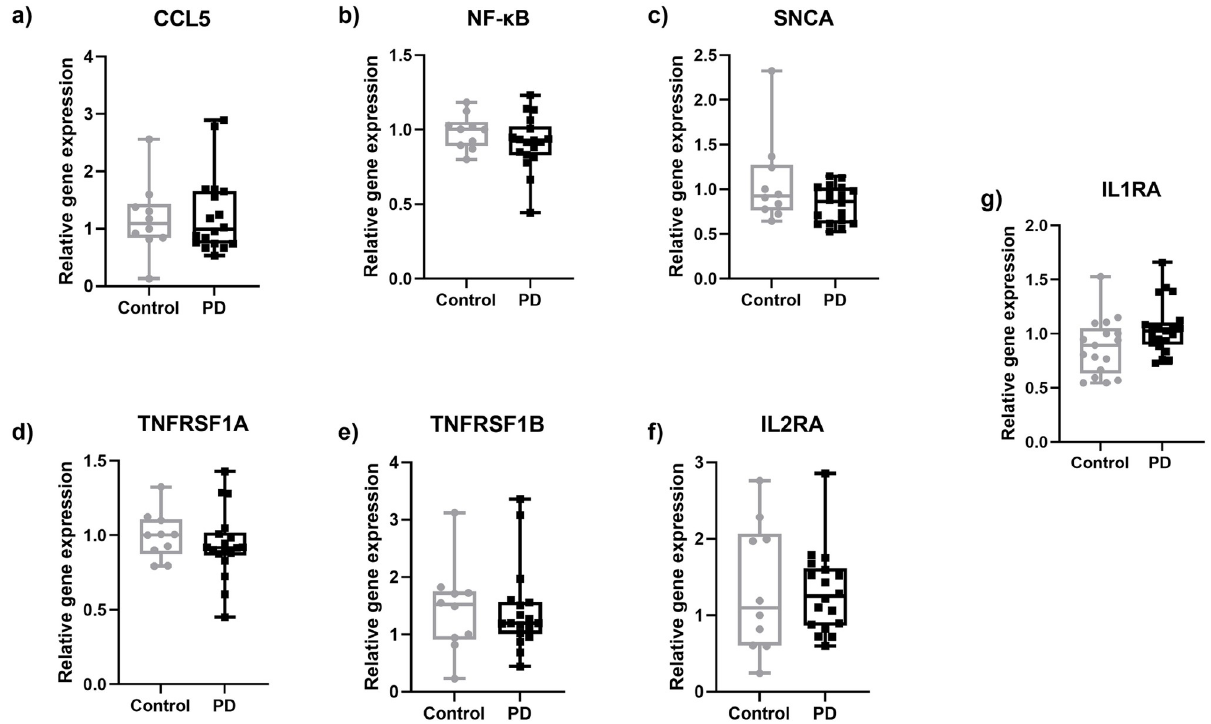
Fig 3. Gene expression of selected markers in skin punch biopsy samples obtained from the lateral lower leg of PD patients and healthy controls. No intergroup differences were found for the investigated markers CCL5 (a), NF κ B (b), SNCA (c), TNFRSF1A (d), TNFRSF1B (e), IL2RA (f), and IL1RA (g) in PD skin biopsies compared to healthy controls. Data are expressed as median and range. Abbreviations: CCL5 = C-C chemokine ligand 5, IL1RA = interleukin 1 receptor A, IL2RA = interleukin 2 receptor A, NF κ B = nuclear factor kappa B, PD = Parkinson’s disease, SNCA = synuclein alpha, TNFRSF1A = TNF receptor superfamily member 1A, TNFRSF1B = TNF receptor superfamily member 1B. Mann-Whitney-U test.